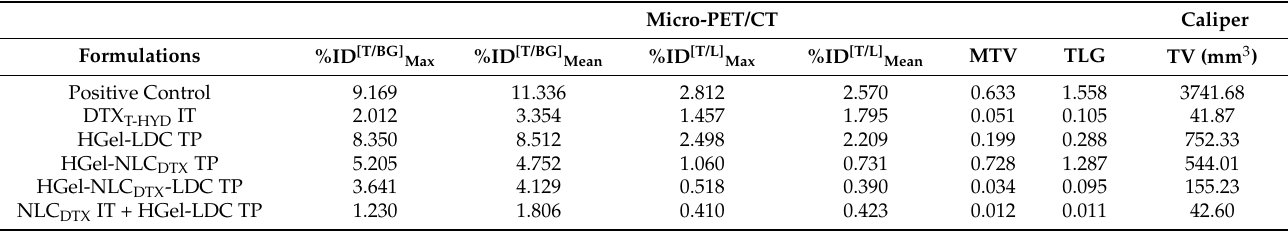
Table 4. Values estimated by micro-PET/CT analysis of the percent ratio of the maximum or mean injected dose between the tumor region and the adjacent tissue (%ID [T/BG] Max and %ID [T/BG] Mean ), or liver (%ID [T/L] Max and %ID [T/L] Mean ); tumor metabolic volume (MTV) and total lesion glycolysis (TLG). The anatomical volume of the tumor (TV) measured with an external caliper is also